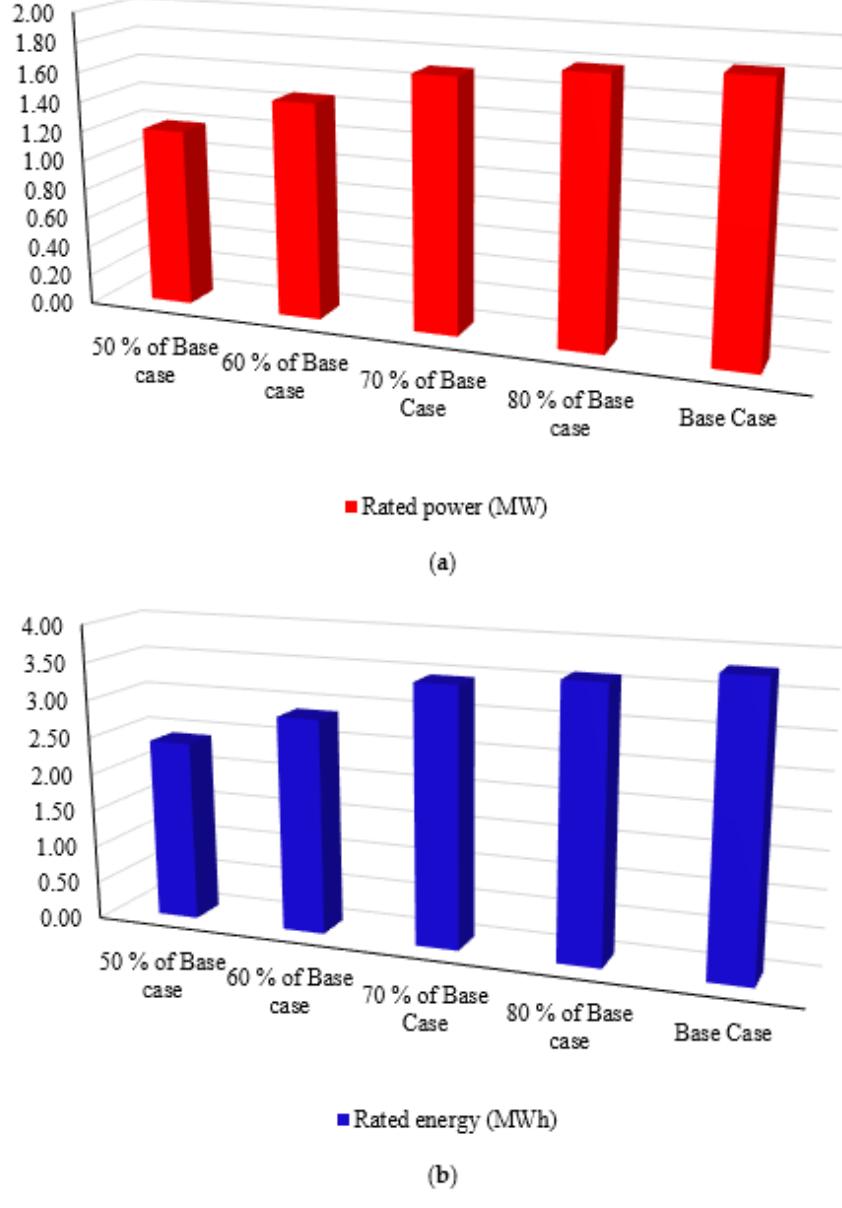
Figure 8. Optimal sizing of the BESS as a result of the sensitivity analysis on the maximum allowable budget ( a ) for power (MW) and ( b ) for rated energy (MWh).